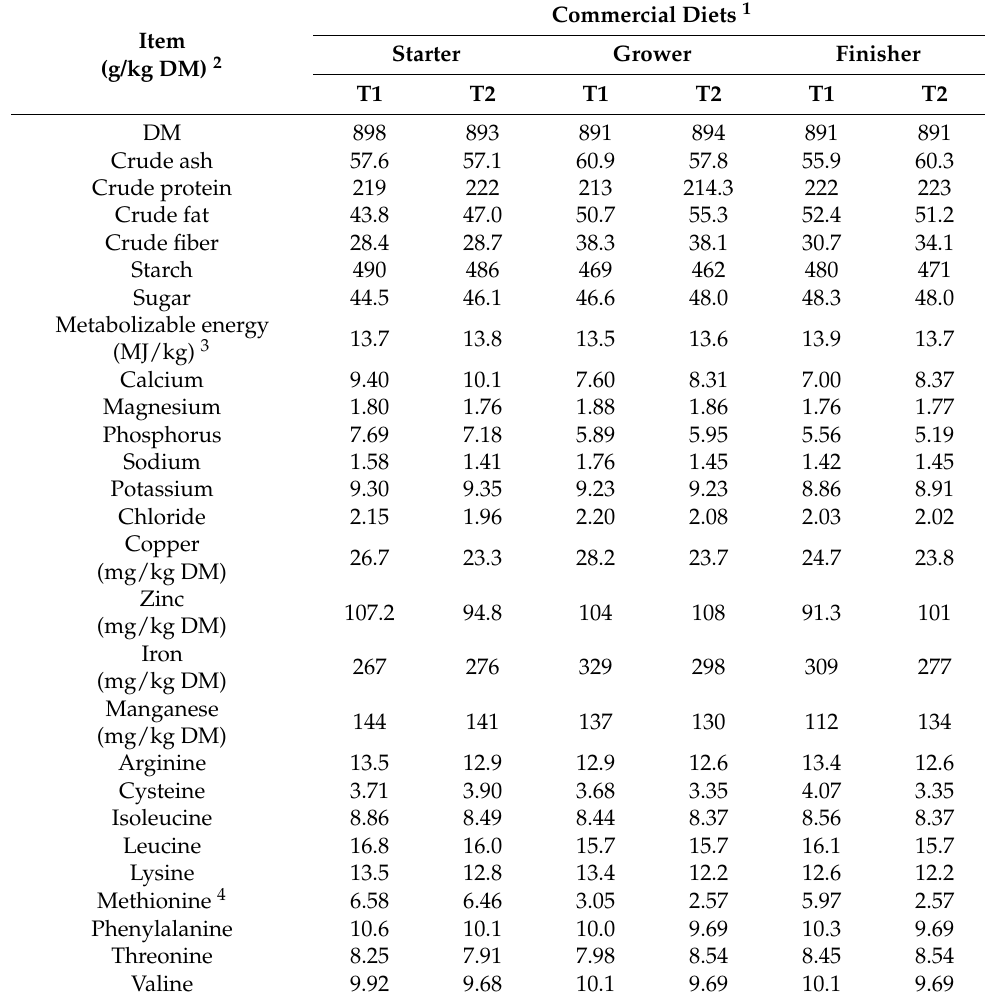
Table 1. Analyzed chemical composition of experimental